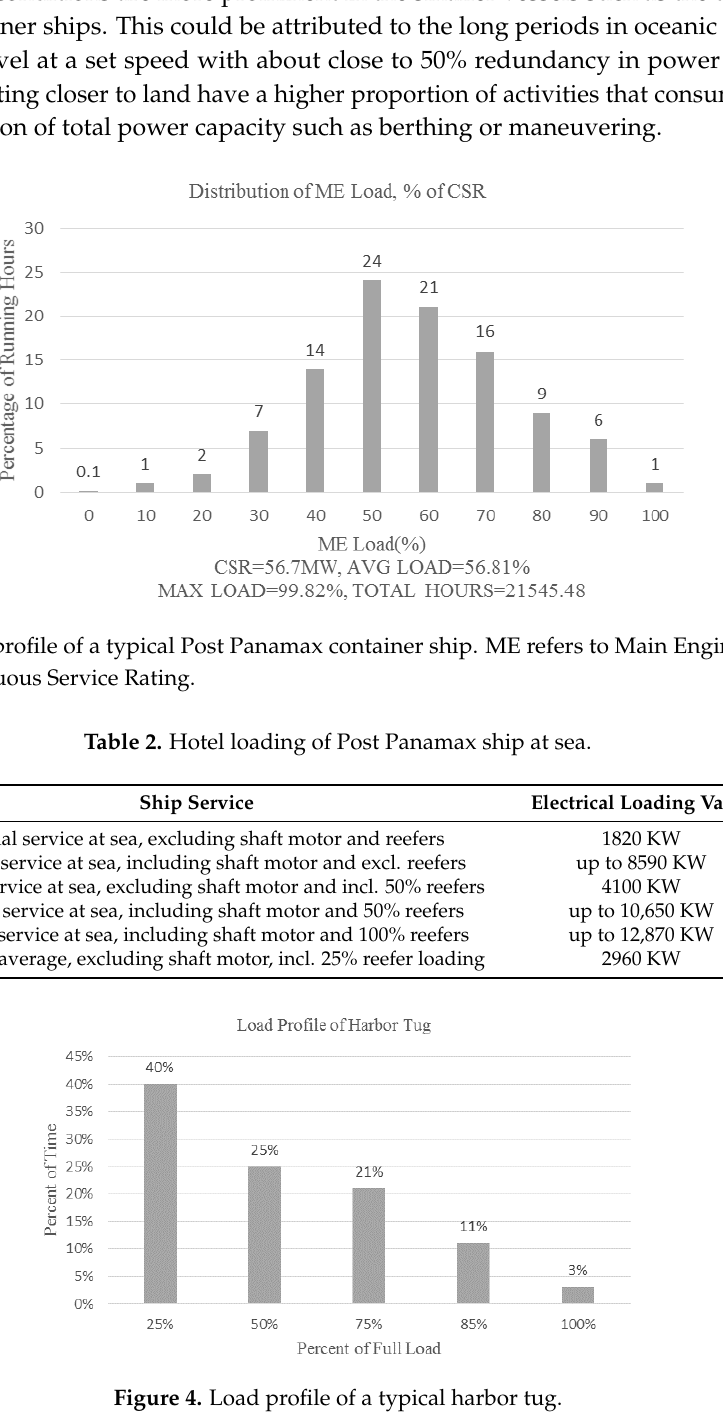
Figure 4. Load profile of a typical harbor tug.